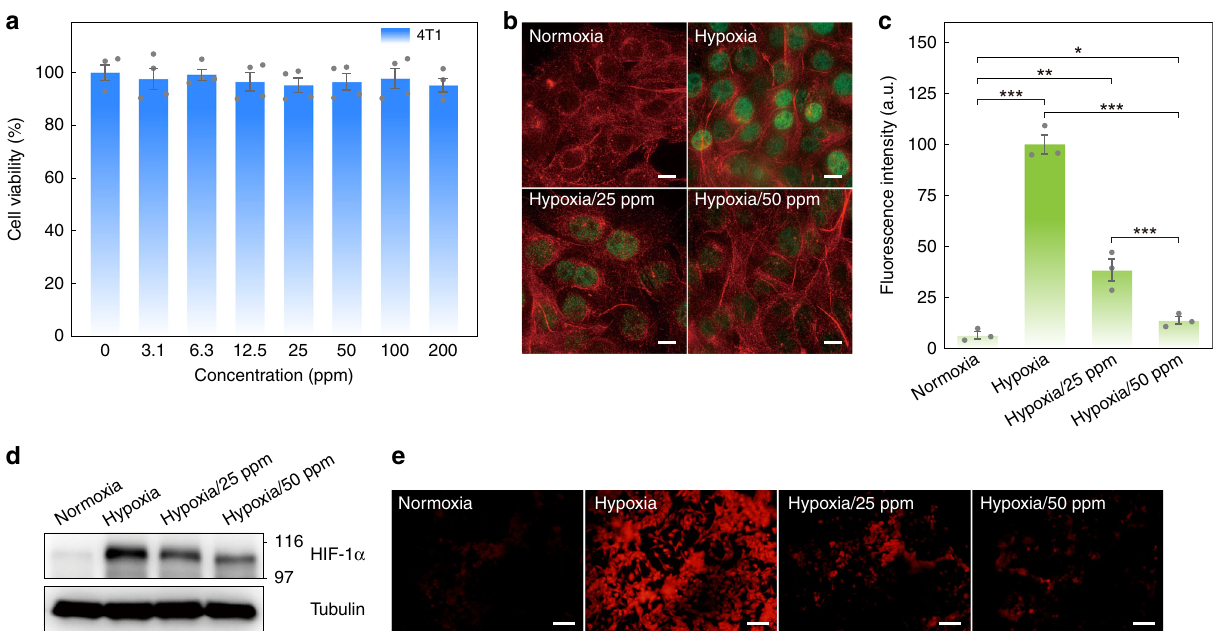
Fig. 5 In vitro biocompatibility, alleviation of hypoxic condition, and intracellular O 2 generation. a 4T1 cells viability after treated with MC-r nanoparticles with different concentrations. Data are presented as mean ± s.e.m. ( n = 4). b Fluorescence imaging of 4T1 cells with stained HIF-1 α (green) and tubulin (red) after treated with PBS under normoxic condition (21% O 2 , 5% CO 2 , and 74% N 2 ) as well as PBS (Hypoxia) and MC-r (Hypoxia/25 ppm and Hypoxia/50 ppm) under hypoxic condition (1% O 2 , 5% CO 2 , and 94% N 2 ). Scale bar is 10 µ m. c Relative intensity of corresponding green fl uorescence from HIF-1 α under different treating conditions. Data are presented as mean ± s.e.m. ( n = 3). Statistical analysis was performed via one-way ANOVA. *p < 0.05, **p < 0.01, ***p < 0.001. d Western blot analysis of HIF-1 α expression in 4T1 cells under different treating conditions. e Fluorescence imaging of 4T1 cells stained by O 2 indicator after treatments with different conditions. Scale bar is 100 µ